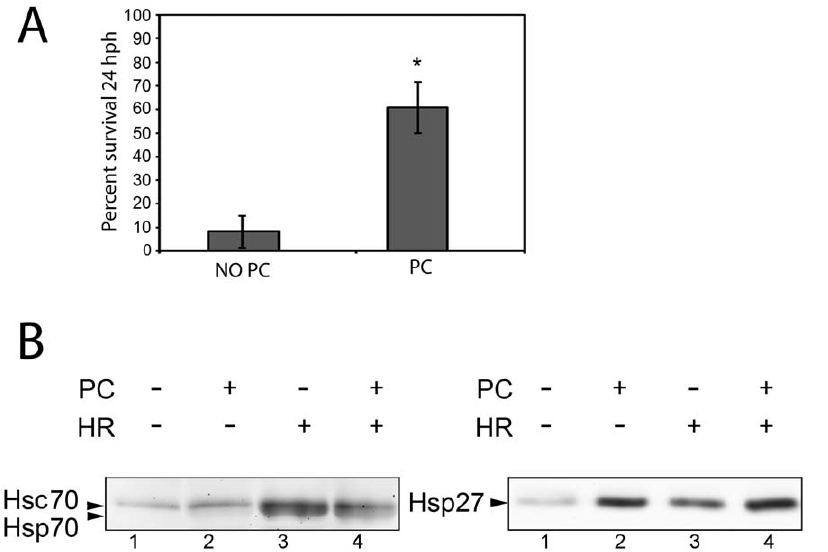
Figure 2. Effect of heat shock preconditioning on embryo survival and heat shock protein expression. A: Average percentage survival of embryos treated at 48 hpf with 160 min of hypoxia. Embryos were either heat shock preconditioned (PC) or not (No PC) and analyzed for survival 24 hours post hypoxia. Data shown are from five independent experiments. Error bars are the SEM. The asterisk indicates a statistically significant difference. B: Representative Western blots showing Hsp70 and Hsp27 expression after heat shock preconditioning and/or hypoxia